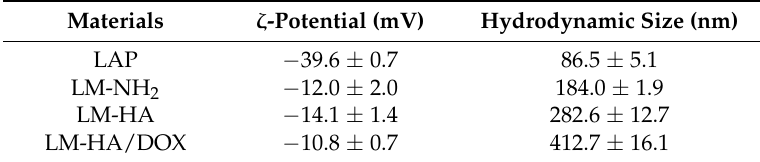
Table 1. ζ -potential and hydrodynamic diameter of LAP, LM-NH 2 , LM-HA, and LM-HA/DOX, respectively. All the samples were dispersed in water at the concentration of 0.5